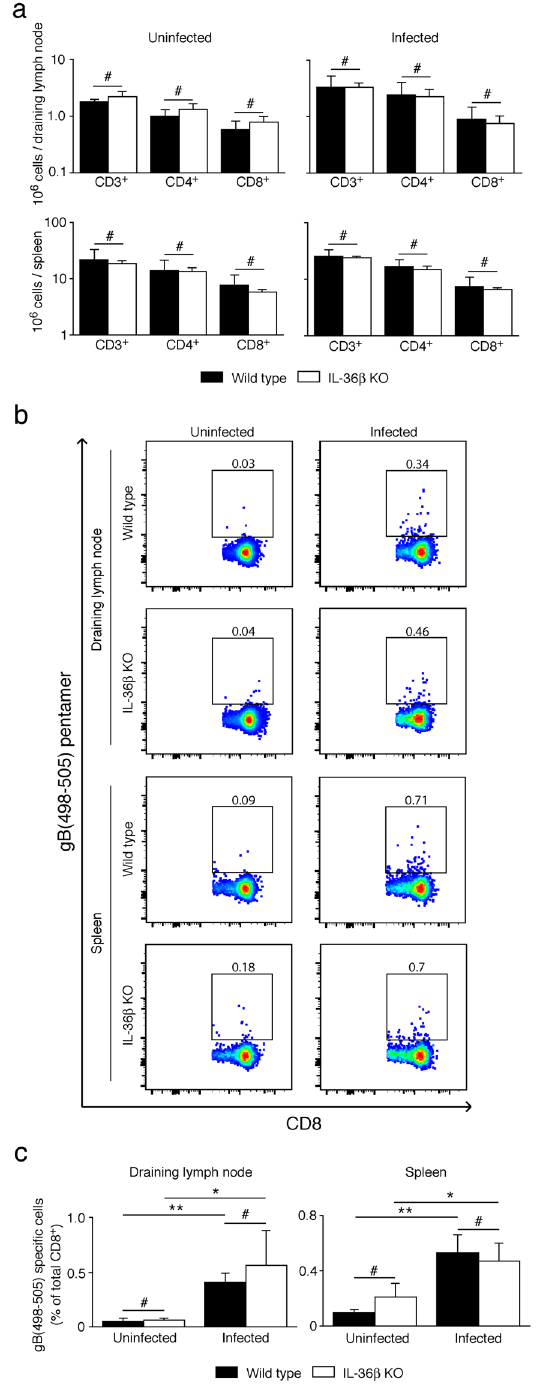
Figure 5. Wild type and IL-36 β KO mice have equal numbers of early HSV-1 gB(498-505) specific CD8 + cells. Wild type and IL-36 β KO mice were infected with HSV-1 (n = 5 per group) as described in Fig. 2 or left uninfected (n = 2–3 per group). Cells were isolated from spleen and draining inguinal lymph nodes 6 days post-infection and analyzed by flow cytometry. ( a ) Total number of CD3, CD4 or CD8 positive cells per organs are shown. ( b ) Cells were examined following initial gating of the CD3 + population. The square gates identify the gB(498–505)/CD8 double positive cells. Numbers above the gates indicate percentage gated cells of all CD8 + cells. ( c ) Graphic representation of gB(498–505) specific CD8 + T cells (means ± SD) quantified in b . One representative experiment of 3 is shown. # p > 0.05; * p < 0.05, ** p <